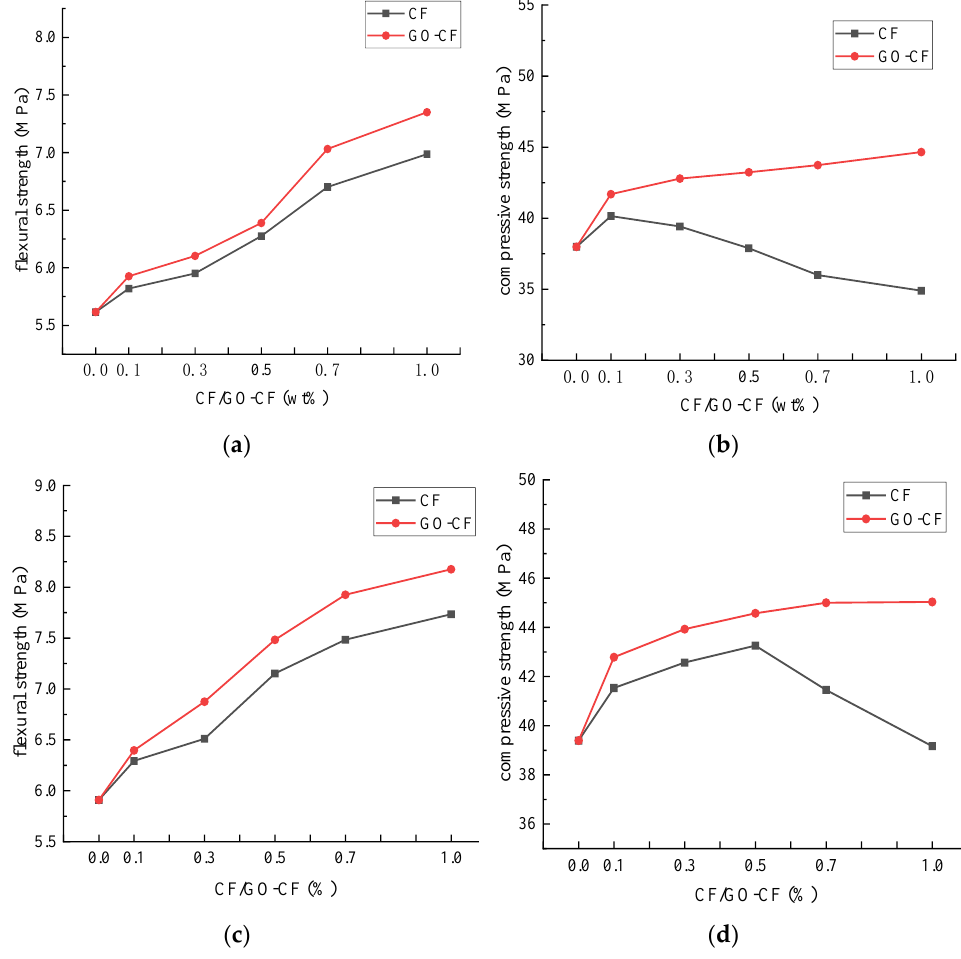
Figure 11. Effect of GO on mechanical properties of cement mortar. ( a ) 7 d flexural strength, ( b ) 7 d compressive strength, ( c ) 28 d flexural strength and ( d ) 28 d compressive strength.